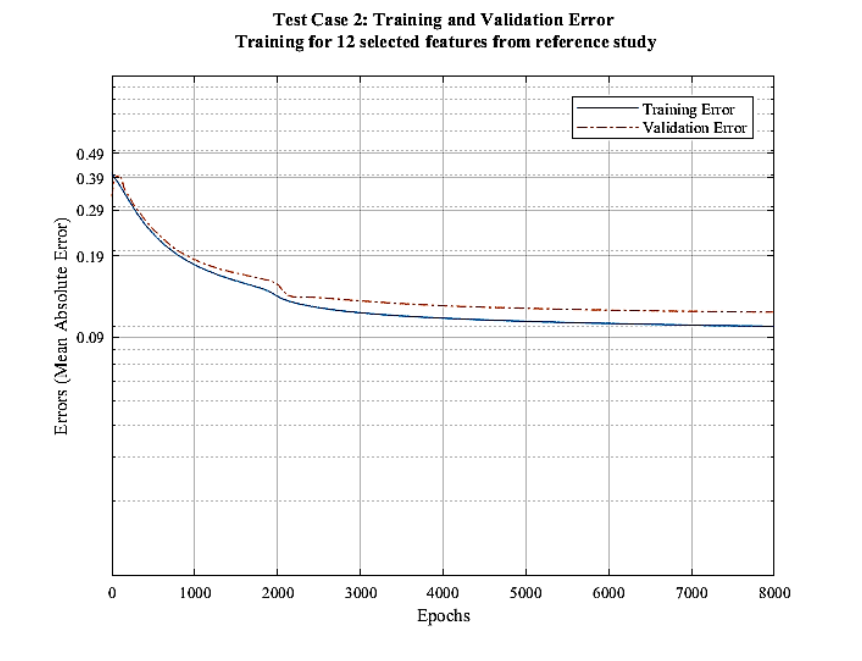
Figure 7. Error vs. epochs graph for test case